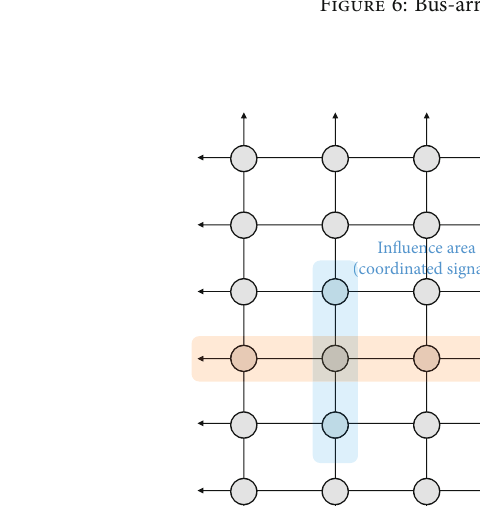
Figure 6: Bus-arrival distribution.